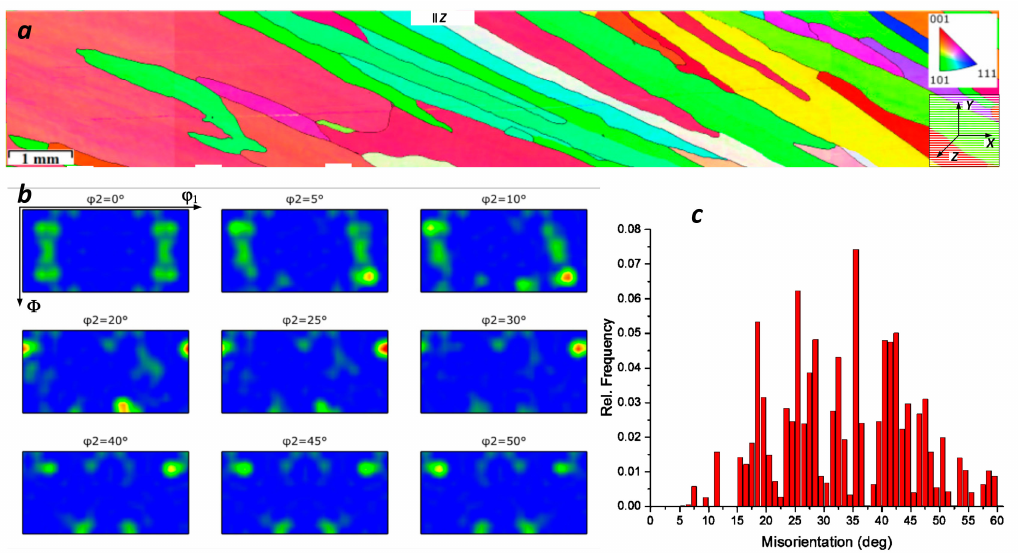
Figure 7. Grain orientation map ( a ), ODF ( b ) and grain boundary misorientation angle distribution ( c ) for as-grown sample 1.